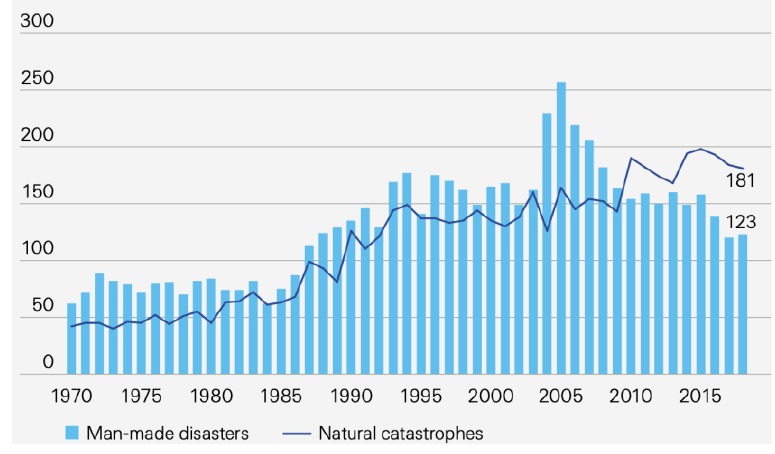
Figure 1. Number of catastrophe events, 1970 – 2018; Swiss RE (2019) [3].